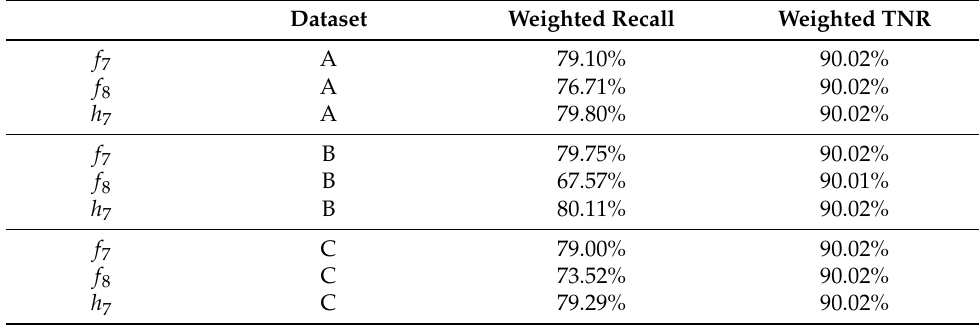
Table 11. Weighted recall and TNR for feature sets f 7 , f 8 and h 7 on different datasets.